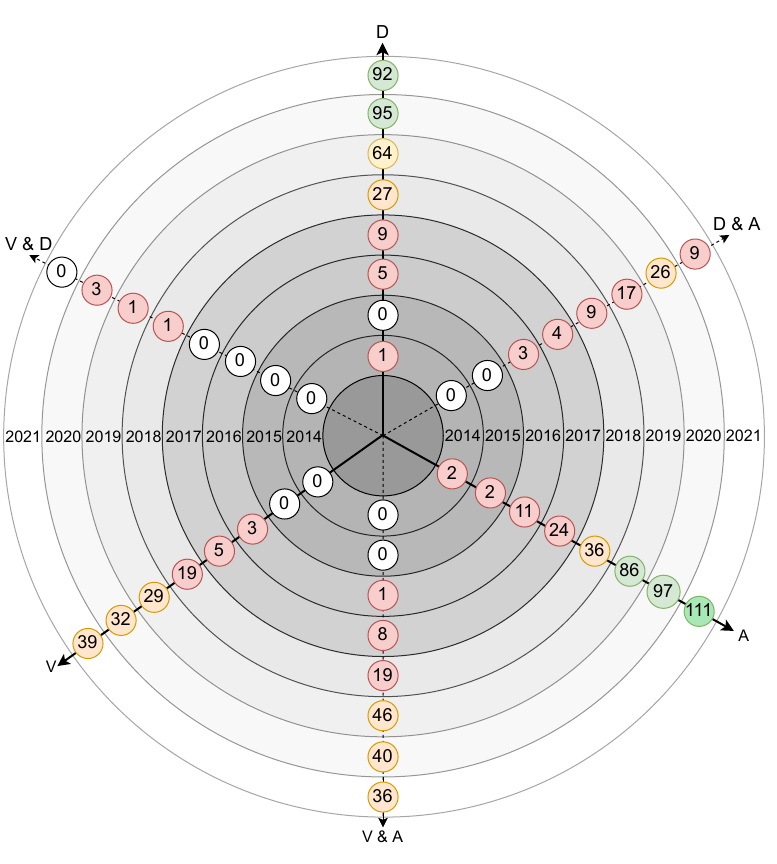
Figure 3. Number of attacks, vulnerabilities and defenses-related papers on multiple axis per year.